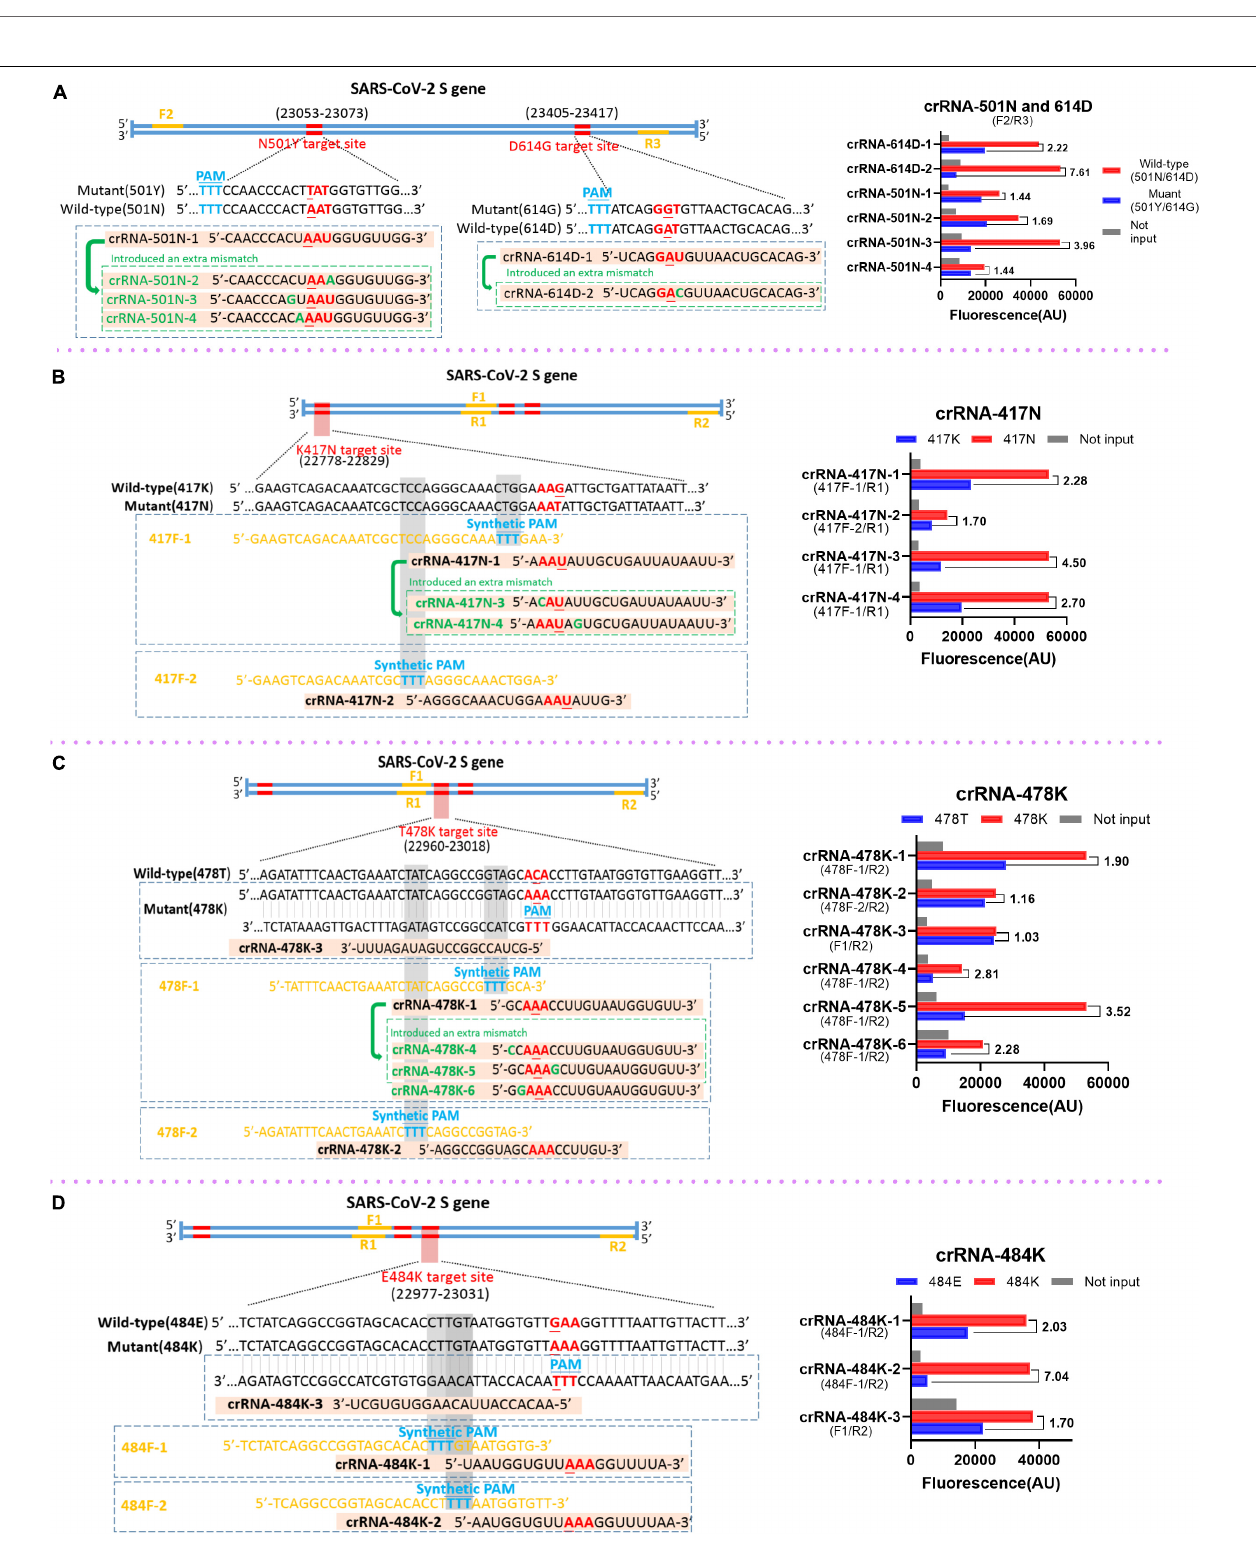
FIGURE 2 | Design and selection of RAA primers and crRNAs. The schematic of the sequences and positions of RAA primers (yellow), the crRNAs with the specific mutations (red), the protospacer adjacent motif PAM (blue) for the mutations of SARS-CoV-2 spike gene (left panel), and the performance of the crRNAs (right panel) for the mutation of N501Y and D614G (A) , K417N (B) , T478K (C) , and E484K (D) , respectively. In the right panels, the wild-type and mutant template were labeled in red and blue, respectively. No input means negative control and was labeled in gray. The RAA primer sets for the corresponding crRNAs are presented within the